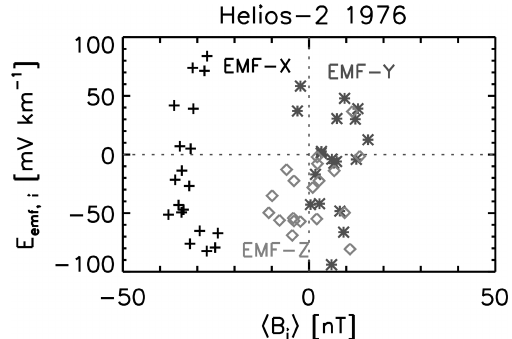
Figure 3. Test for the α effect by plotting the electromotive force E emf as a function of the mean magnetic field (cid:104) B (cid:105) using the Helios- 2 solar wind data near perihelion (0.29au from the Sun) in 1976. The x component (EMF-X) is radially away from the Sun, the y component (EMF-Y) is azimuthally westward (with respect to the ecliptic north), and the z component (EMF-Z) is northward to the ecliptic plane. Figure is produced using the data set presented by Marsch and Tu